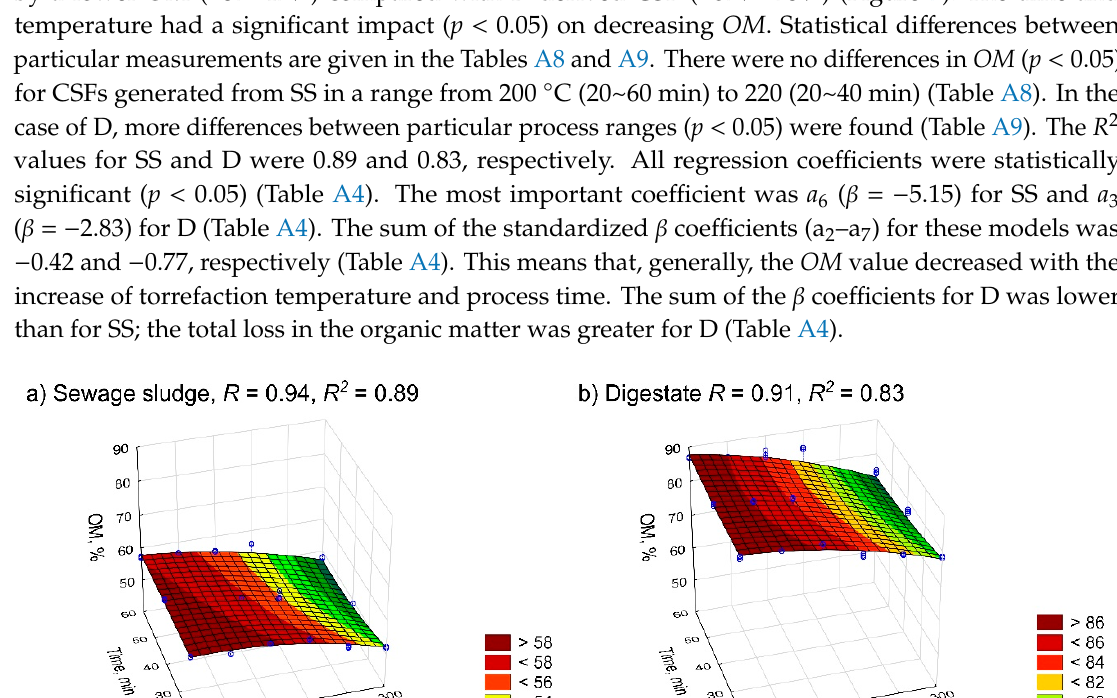
Figure 6. The influence of torrefaction temperature and residence time on the energy yield of CSF from ( a ) sewage sludge and ( b ) digestate. R —correlation coefficient; R 2 —determination coefficient.